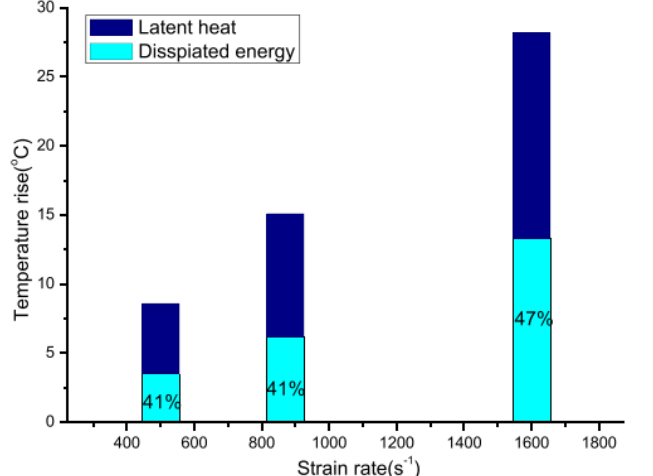
Figure 13. Latent heat and dissipation heat effect on the temperature change [103]. (Reprinted from Ref. [103], Fig. 9, 2019, with permission from the publisher Taylor & Francis Ltd, http://www.tandfonline.com).